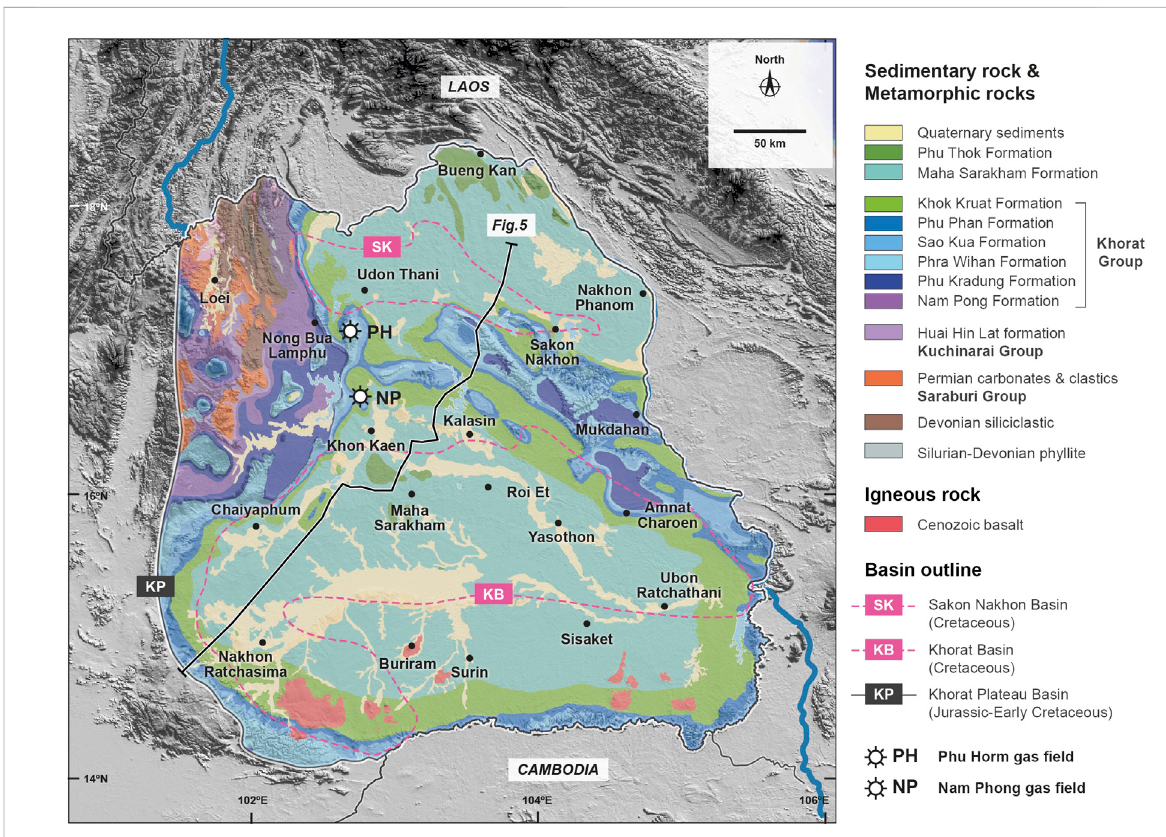
FIGURE 3 Simpli fi ed geological map of the Khorat Plateau, with the main producing gas fi elds (based on Geological Survey Division,